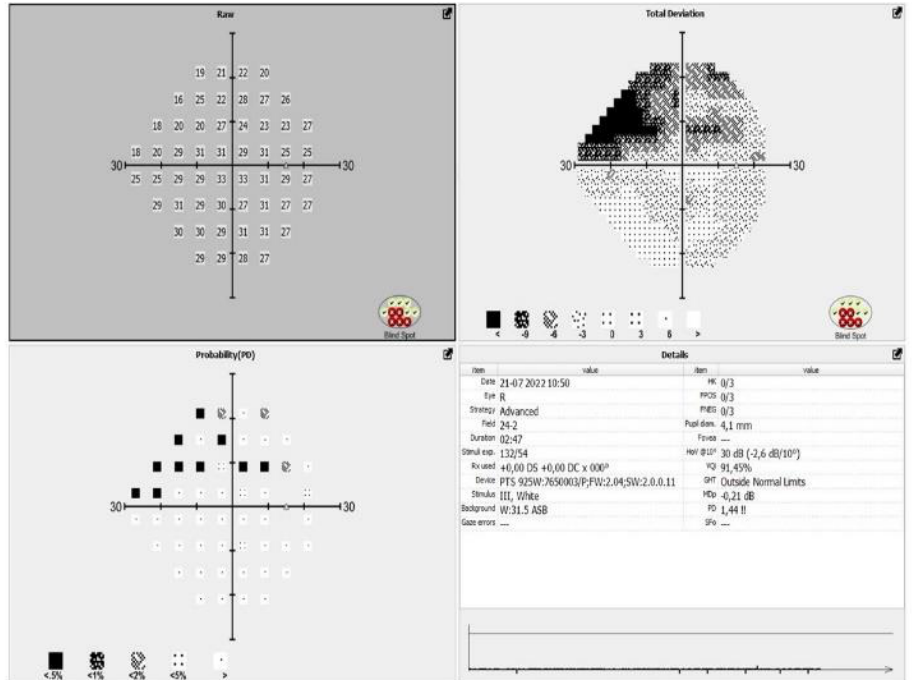
Figure 8. Visual field after the surgical procedure.